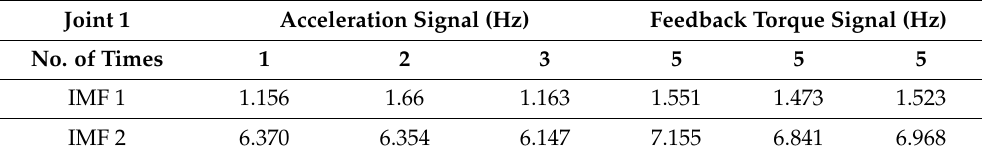
Table 4. Vibration characteristics of the VMD-HHT analysis of joint 1.